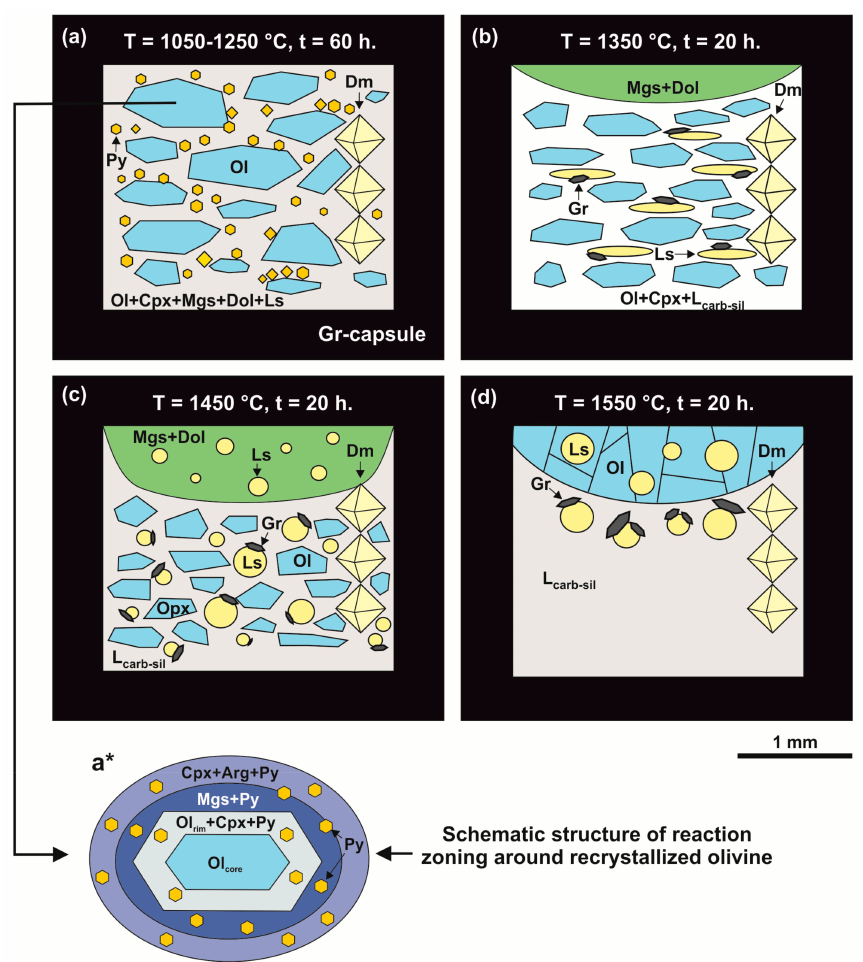
Figure 3. Schemes of samples produced in the olivine-ankerite-sulfur system at pressure of 6.3 GPa in a temperature range of 1050–1550 ◦ C. ( a ): T = 1050–1250 ◦ C; ( b ): T = 1350 ◦ C; ( c ): T = 1450 ◦ C; ( d ): T = 1550 ◦ C; ( a* ): schematic structure of reaction zoning around recrystallized olivine. Py—pyrite, Ol—olivine, Opx—orthopyroxene, Mgs—magnesite, Dol—dolomite, Gr—graphite, Ls—sulfur melt,